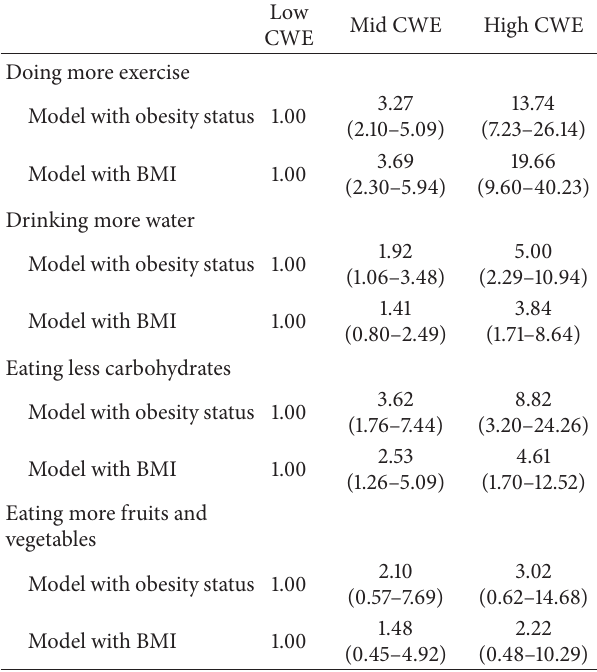
Table 3: Odds of losing at least 5% of body weight in the past